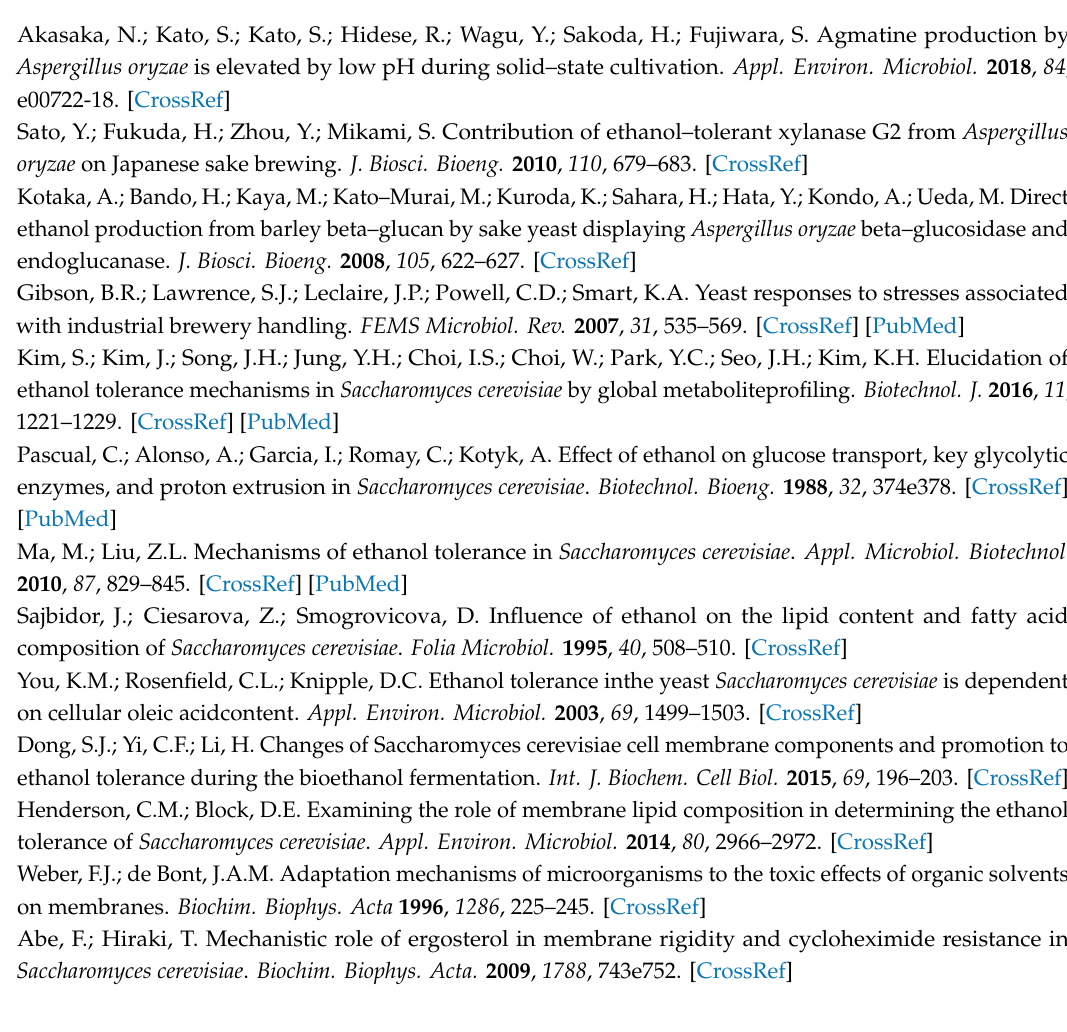
Figure S1: Alterations in the intracellular fatty acid proportions in response to 4% ethanol 36 h post-treatment. The bars represent the average ( ± SE) of the biological repeats. The asterisks indicate statistically significant di ff erences between groups (Student’s t -test): * denotes p < 0.05. Table S1: Primers used in quantitative real-time